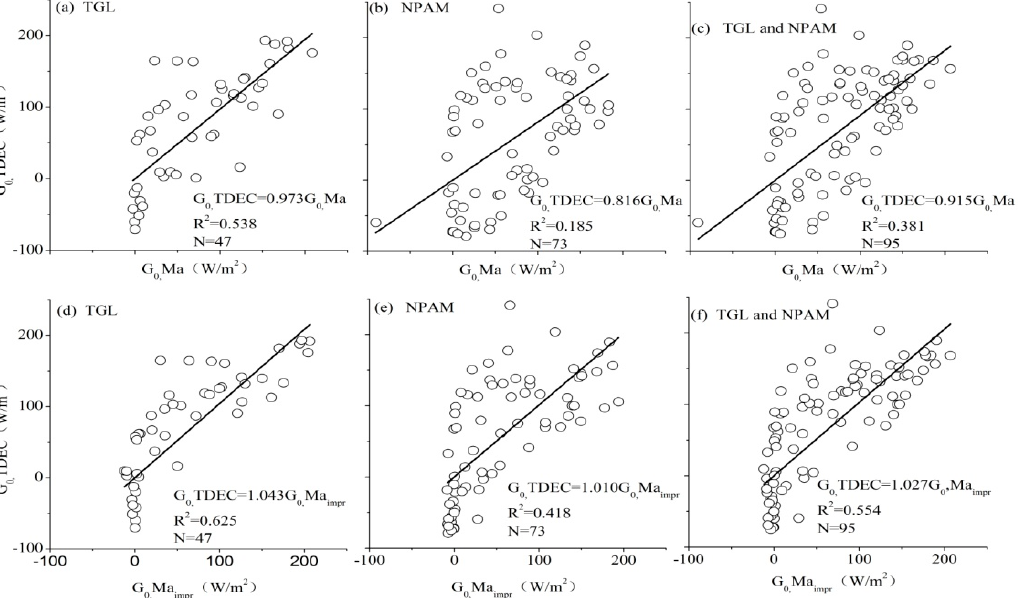
impr and Ma schemes at each